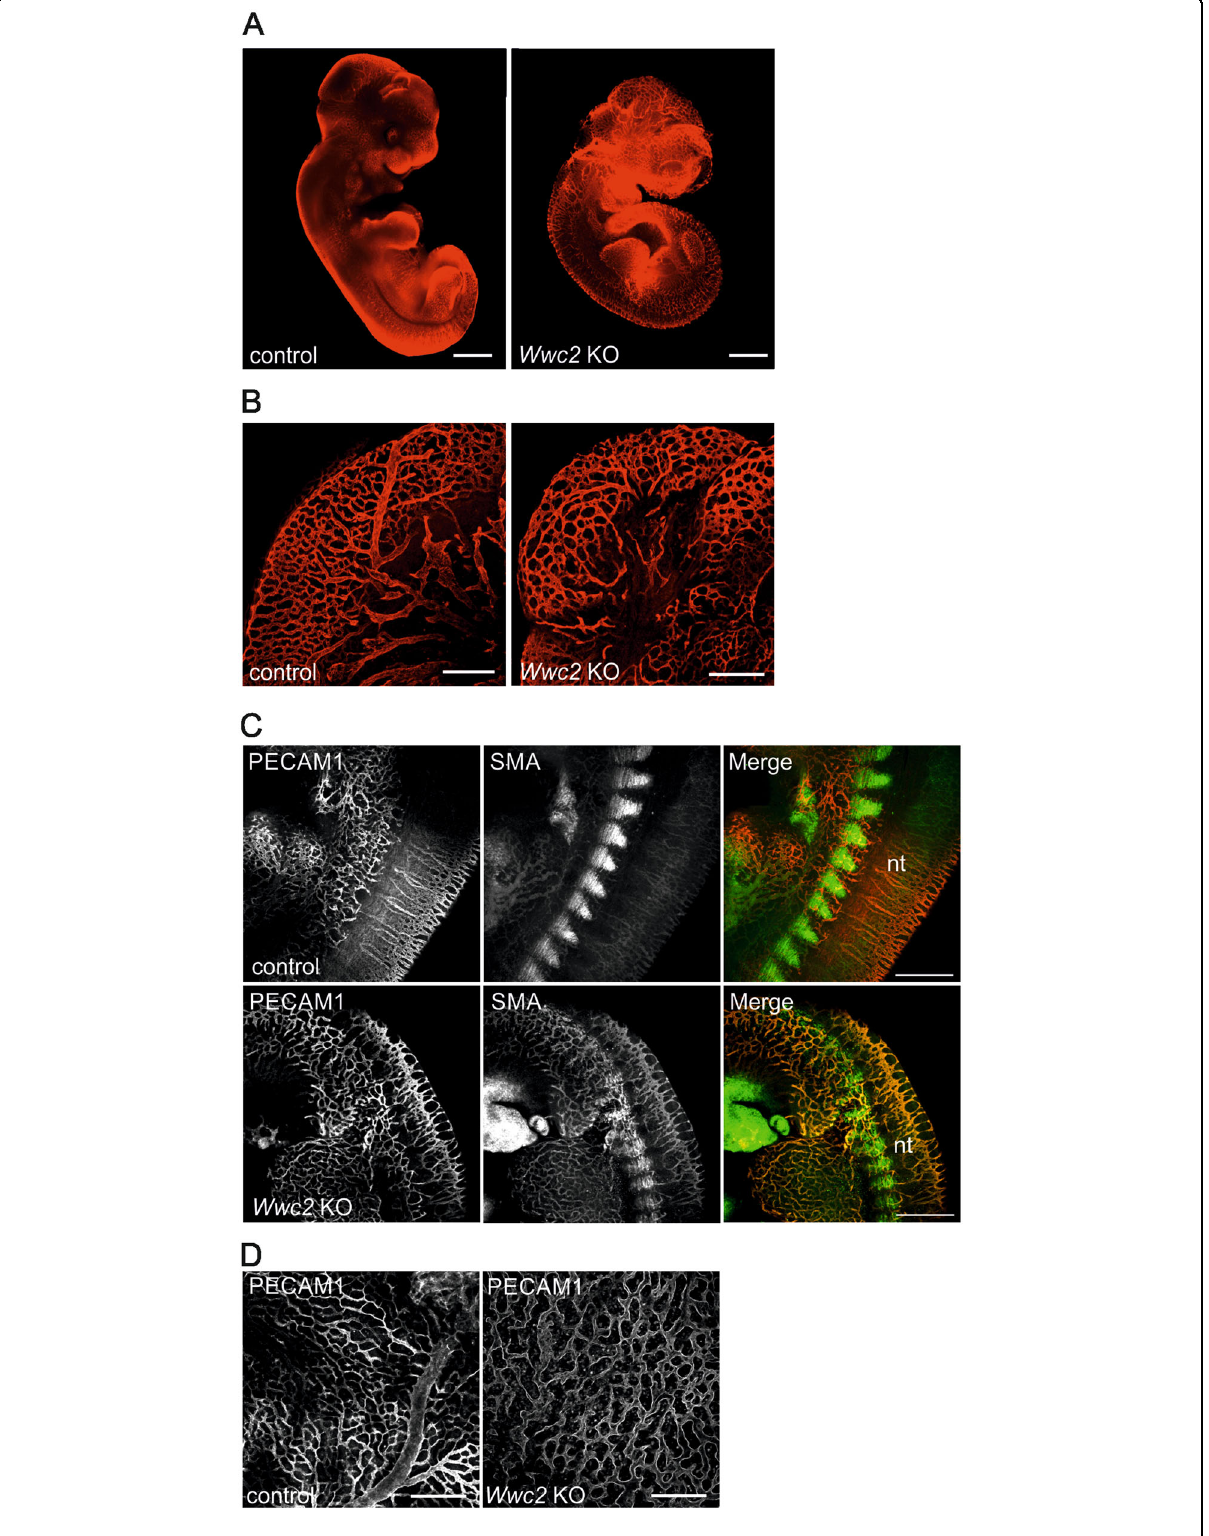
Fig. 4 (See legend on next